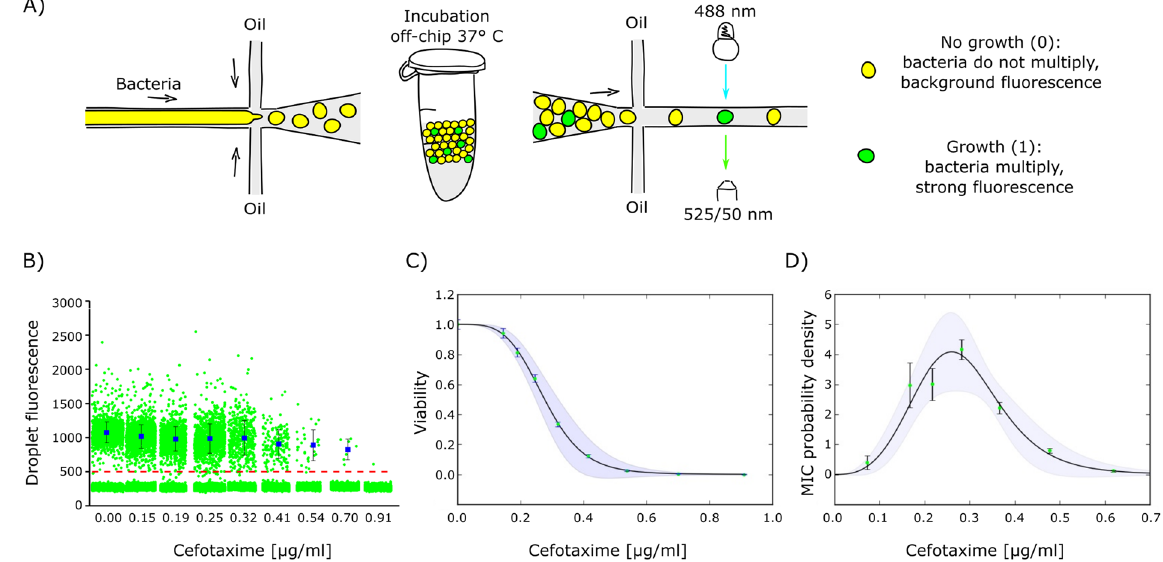
Figure 1. Cefotaxime reveals an E. coli heteroresistance pattern at the single-cell level. ( A ) Microfluidic workflow for the single-cell droplet assay in which an aqueous phase (consisting of bacteria, medium, and antibiotics) are encapsulated in surfactant-stabilized water-in-oil droplets. Each antibiotic concentration is screened in a separate library. During incubation, encapsulated bacteria start proliferating and synthesizing YFP, unless growth is inhibited by the antibiotic. After incubation, the fluorescence readout of each droplet is acquired with confocal microscopy. In principle, the assay is ‘digital’: the bacterium either grows (1-positive) or does not (0-negative). ( B ) Signal intensities of each droplet in the experiment (~10000 droplets per antibiotic concentration of which ~1500 droplets contained bacteria). Red dashed line at relative fluorescence value 500 marks the threshold for positive droplets. Blue rectangles show the average signal of positive droplets, with standard deviation as error bars. ( C ) Cell viability (fraction of positive droplets normalized by the value for the experiment without antibiotic, ) as a function of antibiotic concentration c . Error bars are discussed in f (0) c + f + Fig. S5. Continuous line represents determined by the least-square method. Errors and the error propagation formula applied to the fit determine the shaded area. ( D ) Probability distribution of individual MICs in the population obtained from a numerical derivative of the data points in ( C ). Continuous line represents the negative derivative of the fit from ( C ) (the probability distribution of single- cell MICs in the population). The shaded area shows errors obtained from the error propagation formula applied to the negative derivative of fit from ( C